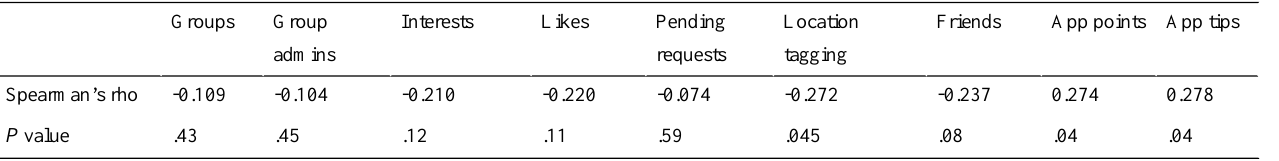
Table 3. Spearman rank correlation coefficients between Facebook social features and the CES-D